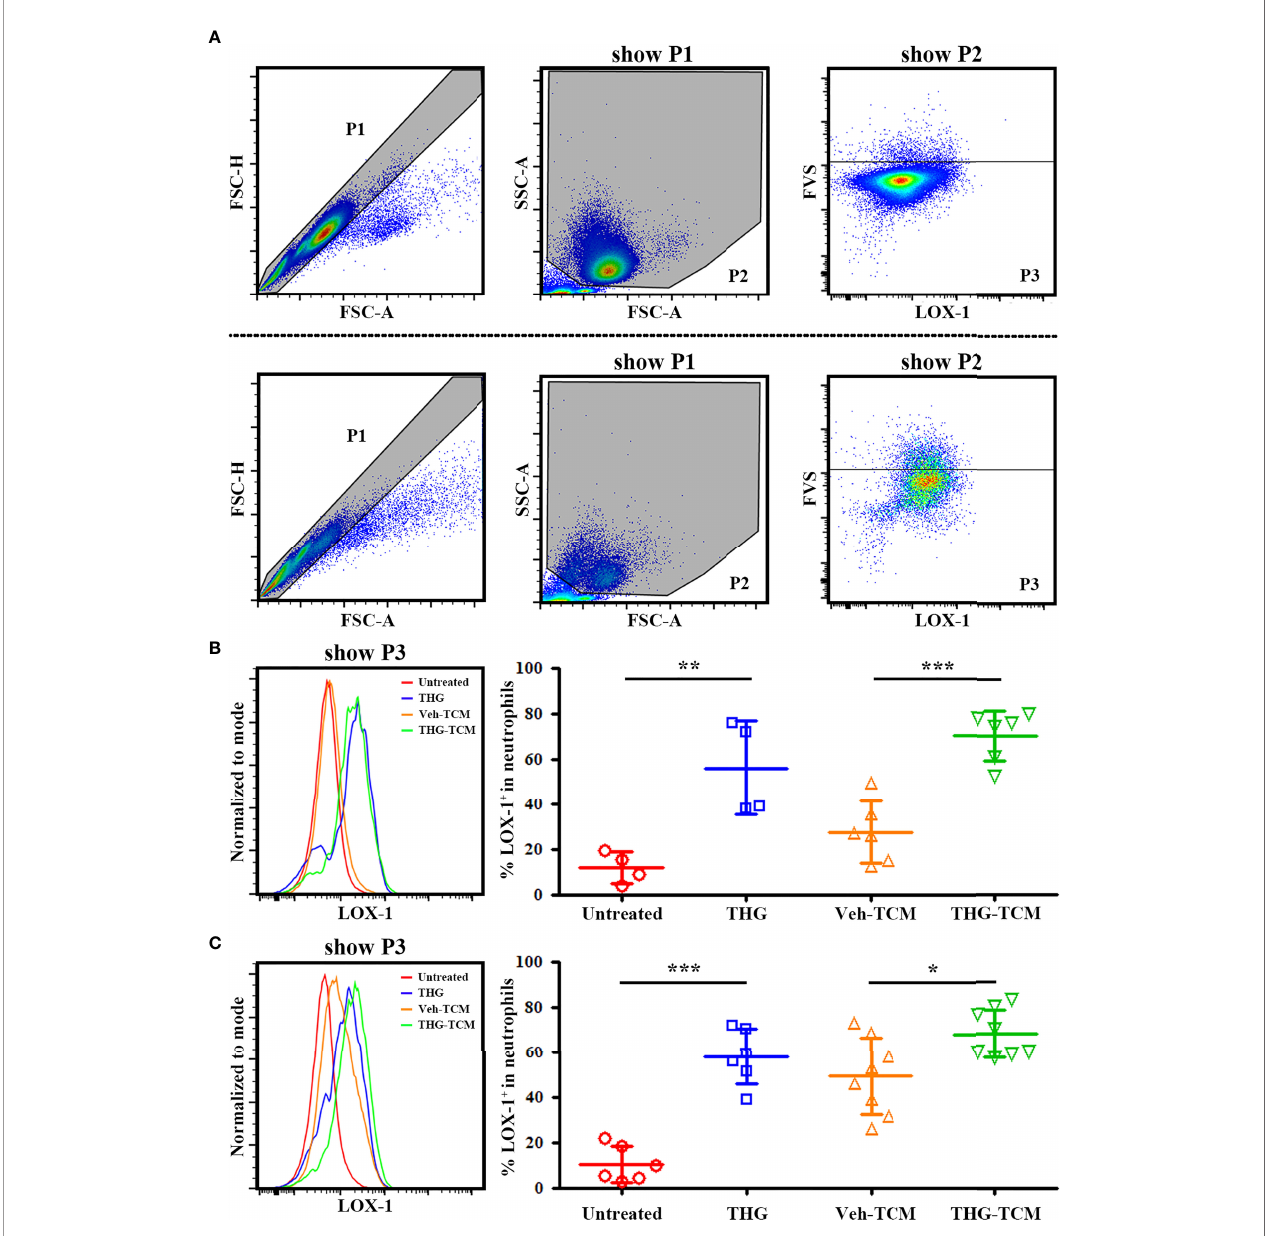
FIGURE 2 | Endoplasmic reticulum (ER) stressed tumor conditioned medium (TCM) induced lectin-like oxidized low-density lipoprotein receptor-1 (LOX-1) expression on neutrophils. Both SCC25 and OML1 cells were treated with vehicle or 2 m M thapsigargin (THG) for 4 hours and then cultured in renewed medium. After 20 hours, conditioned medium was collected from vehicle-treated cells (Veh-TCM) or THG-treated cells (THG-TCM). Freshly isolated human neutrophils were then cultured with vehicle (untreated neut), 0.5 m M THG (THG-neut), Veh-TCM, or THG-TCM in the presence of 10 ng/ml GM-CSF. Untreated neut and THG-neut were served as negative or positive controls respectively. After 4 hours of incubation, LOX-1 expression on neutrophils after different treatment was evaluated by fl ow cytometry. (A) The representative gating strategy for Veh-TCM treated neutrophils (upper panel) or THG-TCM treated neutrophils (lower panel). Live neutrophils were fi nally gated as fi xable vial stain (FVS) - (P3). Then the LOX-1 expression of live neutrophils (P3) after culture in TCM from SCC25 (B) or OML1 (C) were shown. Higher percentages of LOX-1 + neutrophils were detected after culture in THG-TCM compared with Veh-TCM. Data were collected from 4 different (B) and 6 different (C) donors respectively and shown as mean ± SD. * p < 0.05, ** p < 0.01, *** p < 0.001. FSC, forward scatter; SSC, side